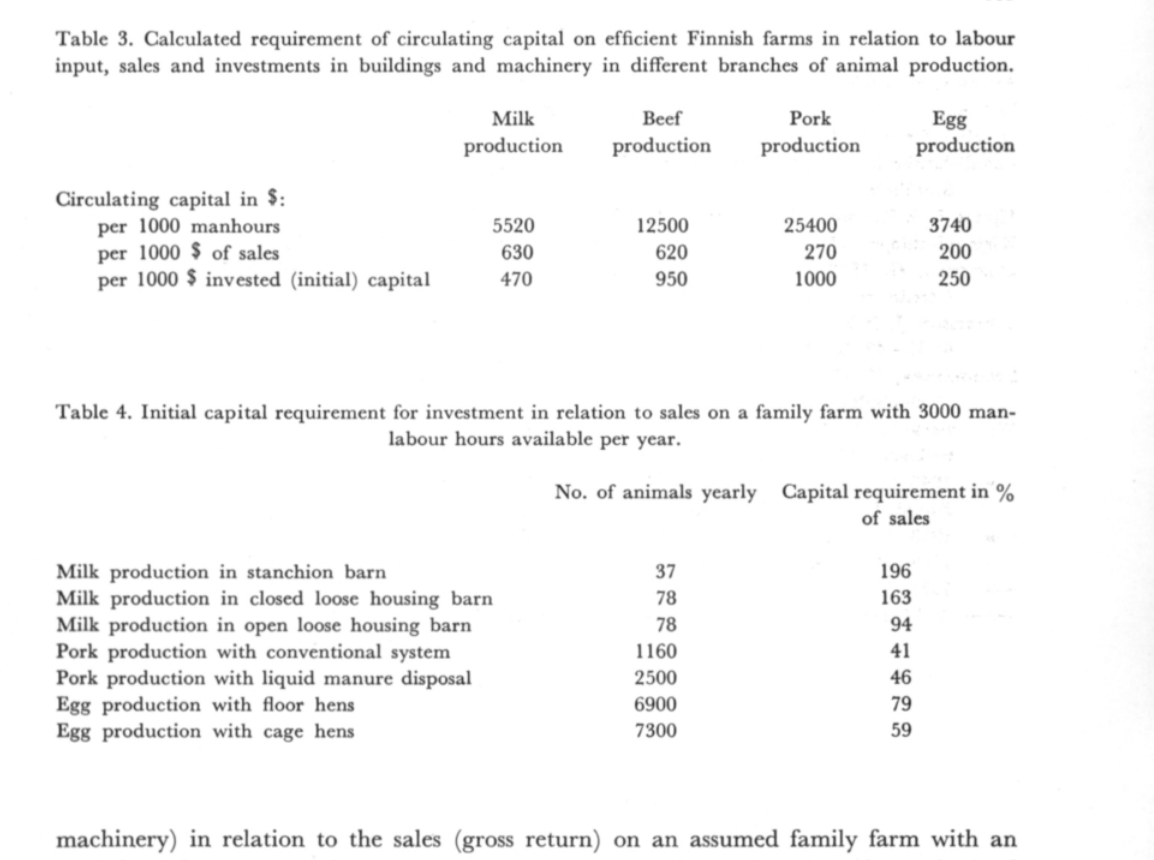
Table 3. Calculated requirement of circulating capital on efficient Finnish farms in relation to labour input, sales and investments in buildings and machinery in different branches of animal production.